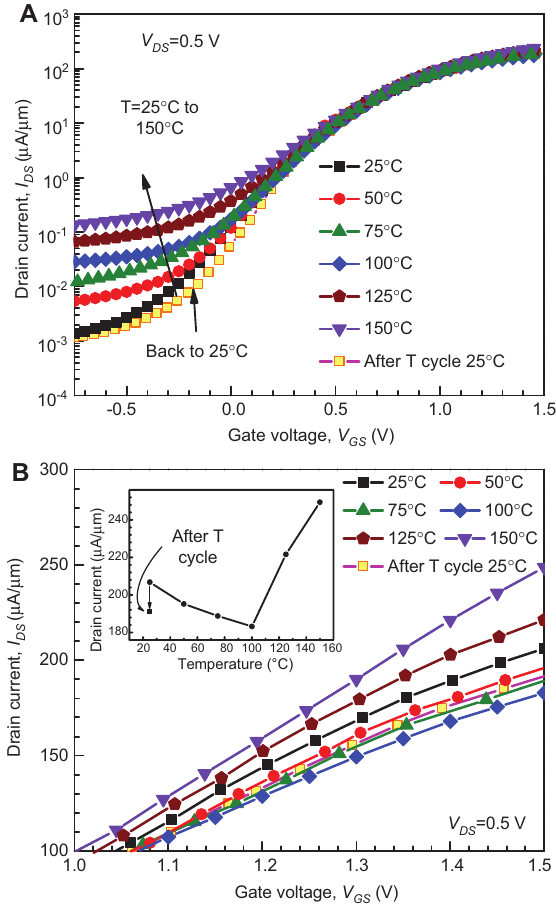
- V ) characteristics of GaAs Figure 39 (A) Transfer ( I DS GS = 0.5 V with I In Ga As TFET devices at V 0.7 0.3 DS to 150 ° C. (B) I ( V from 1.0 V to 1.5 V) of TFET devices at V DS GS